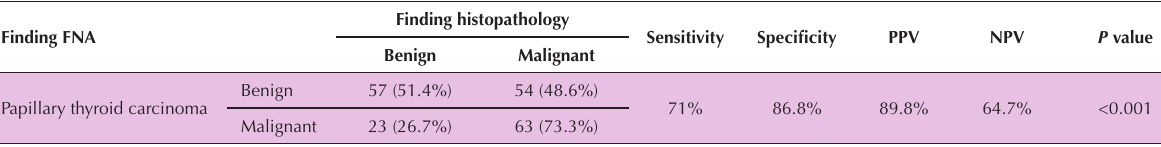
Table 1. FNA diagnostic compliance with its surgical specimens Finding